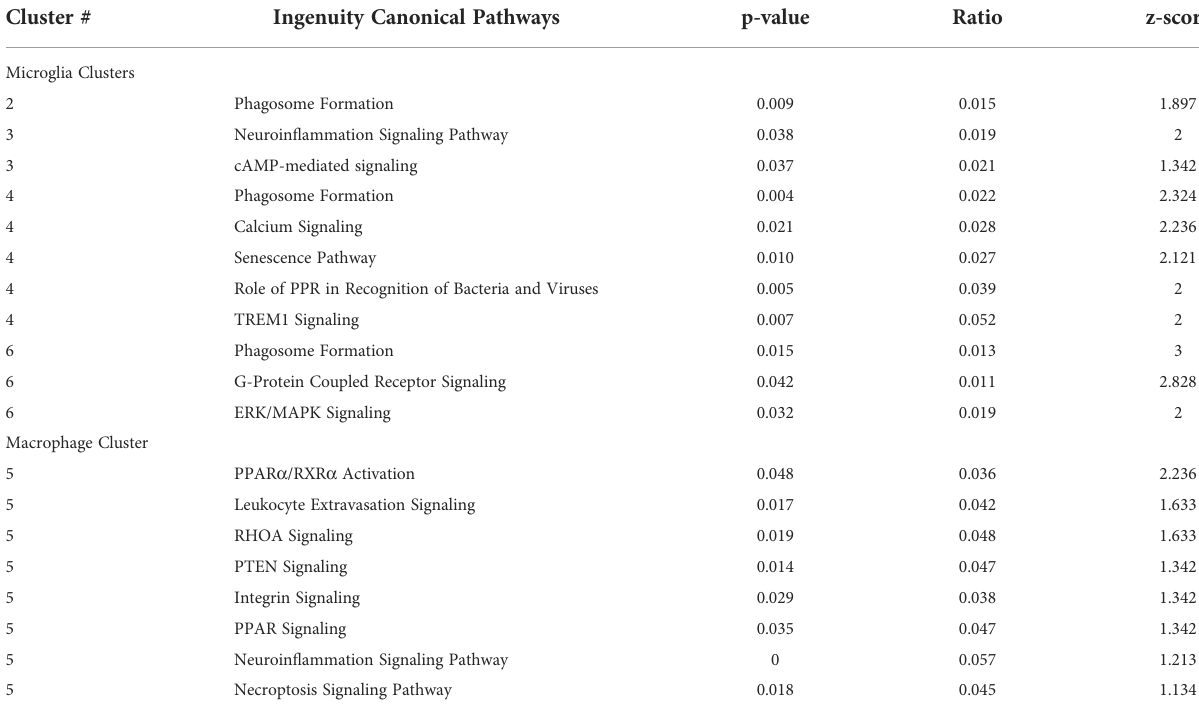
TABLE 2 IPA canonical